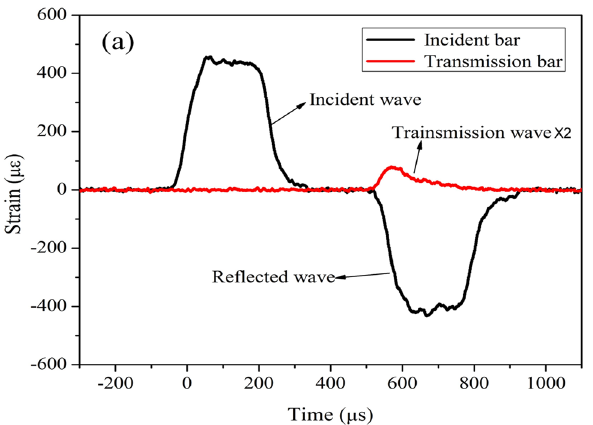
Figure 7. Typical incident, reflected, and transmitted waves in SPHB tests: ( a ) concrete BD specimens, where the transmitted wave signal in the latter is amplified twice to aid